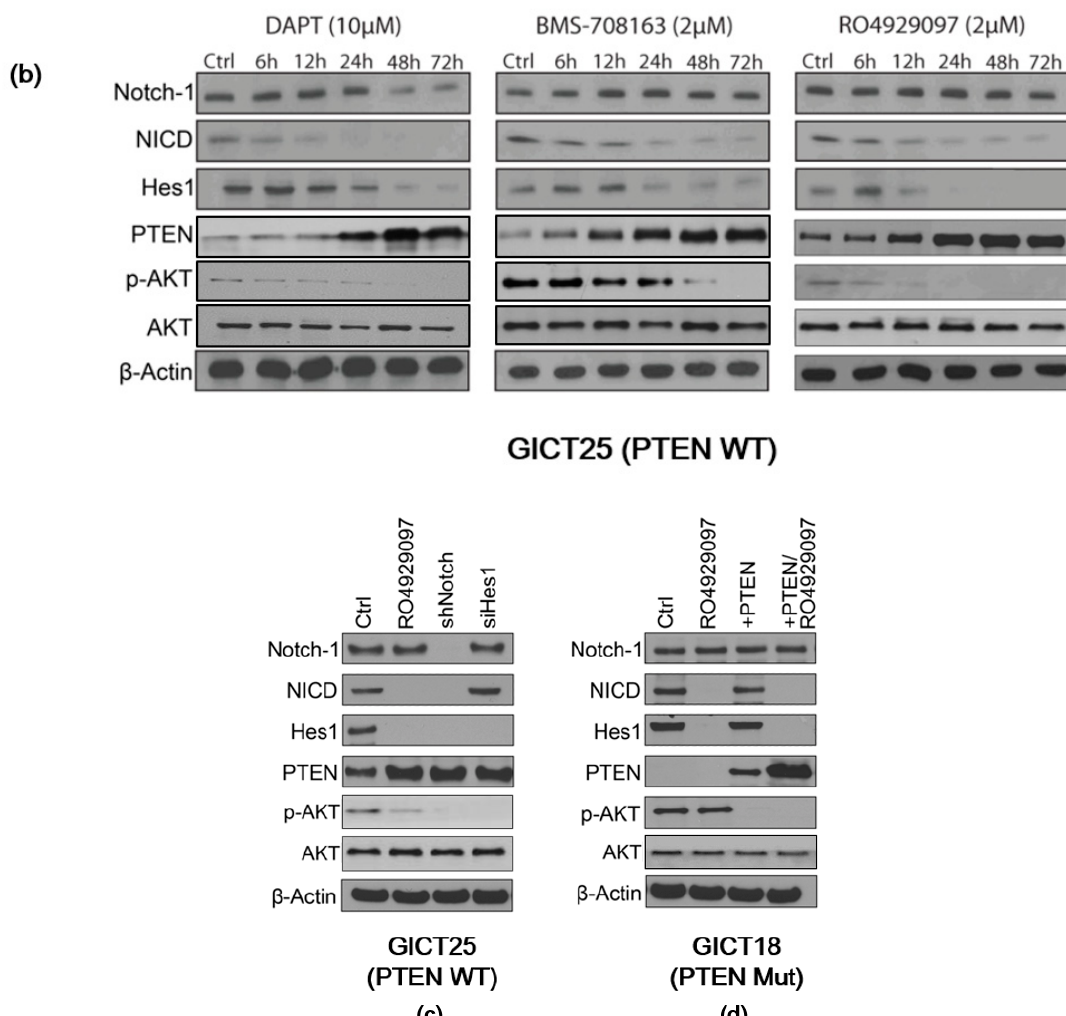
Figure 3. ( a ) Real-time PCR analysis of PTEN transcript levels upon NOTCH-1 inhibition by GSI in GICT25 and GICT14 relative to (DMSO) controls. GAPDH levels were used as the reference control; ( b ) A GICT25 panel was treated with the indicated doses of DAPT, BMS-708163 and RO4929097 for the indicated time intervals. All GSIs inhibited the expression of NICD, Hes1 and p-AKT in a time-dependent manner. The decrease in NICD was followed by a decrease in Hes1 expression, whereas Notch-1 expression did not change; ( c ) Western blotting confirmed the knockdown effect of Notch shRNA lentivirus on GICT25. siRNA knockdown of Hes1 decreased HES1 expression and increased PTEN expression; ( d ) After transfection with the PTEN gene, PTEN expression increased with GSI treatment.